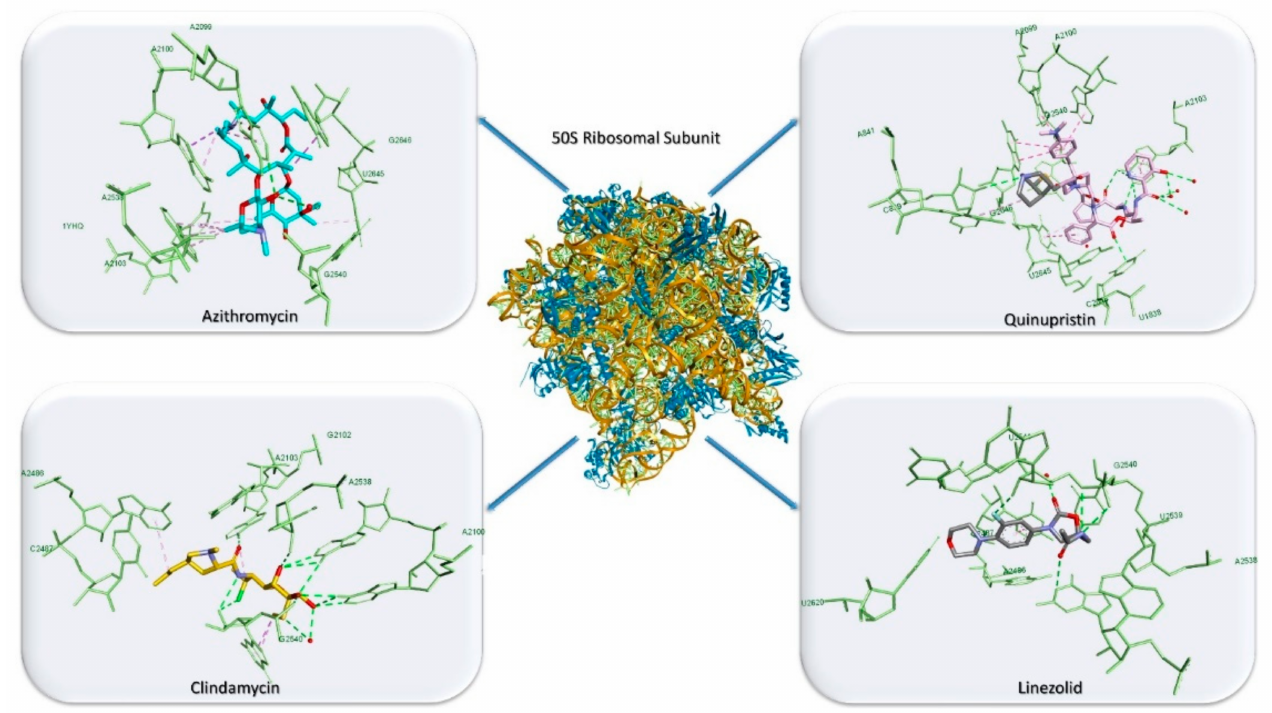
Figure 4. Molecular interactions of 50S ribosomal subunit targeting antibiotics, azithromycin (light blue), clindamycin (orange), quinupristin (pink) and linezolid (grey): HB are depicted as green dotted lines and hydrophobic interactions are depicted as purple dotted lines. The figure was built with Biovia Discovery Studio 4.1 using the PDB entries 1YHQ, 1YJW, 3CPW and 1YJN